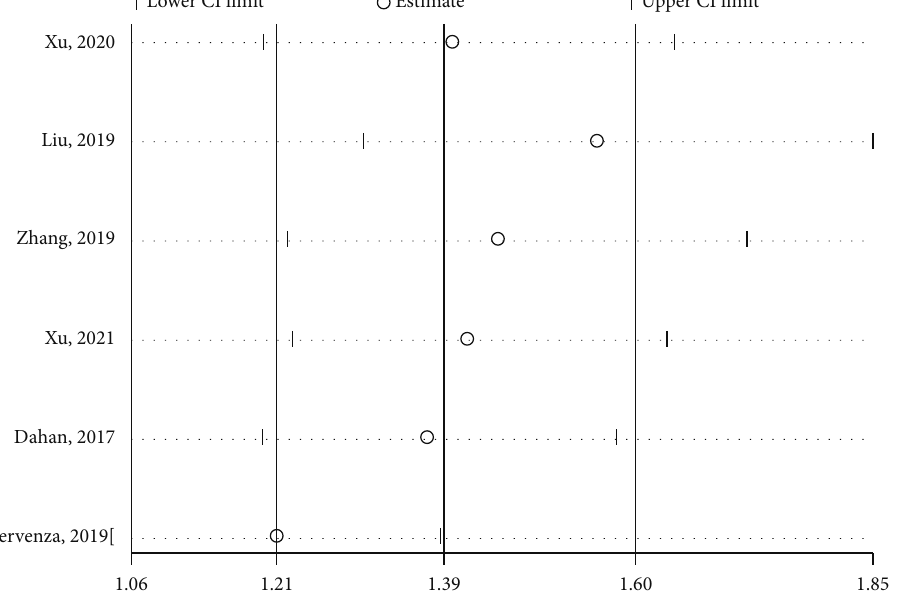
Figure 3: Sensitivity analysis of the total e ff ective rate.